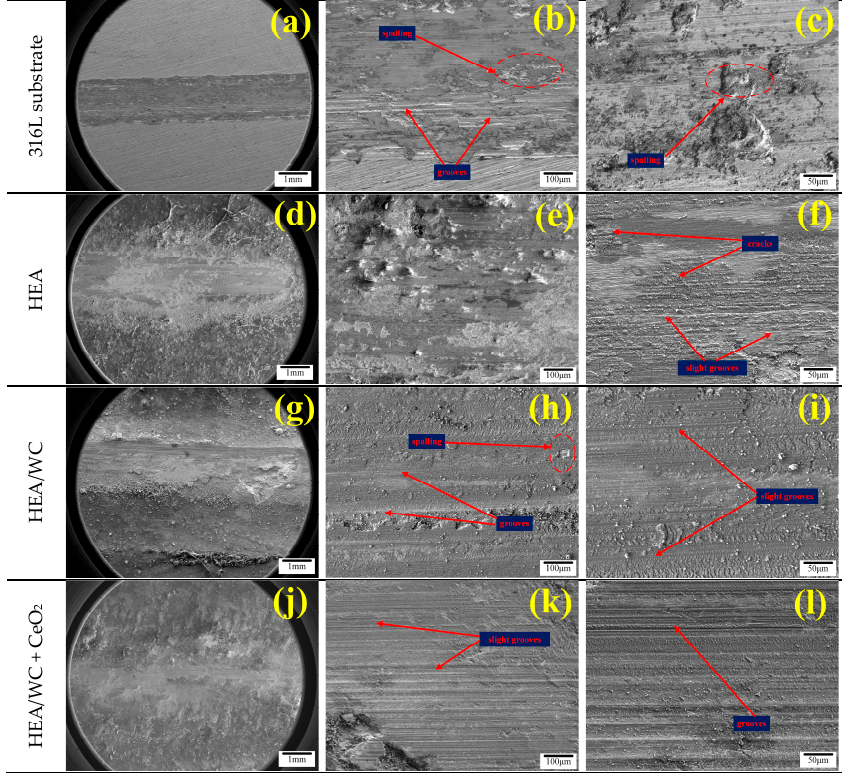
Figure 10. Microscopic morphology of the substrate and the three coating surfaces after wear: ( a – c ) 316L substrate; ( d – f ) HEA; ( g – i ) HEA/WC; ( j – l ) HEA/WC + CeO 2 .